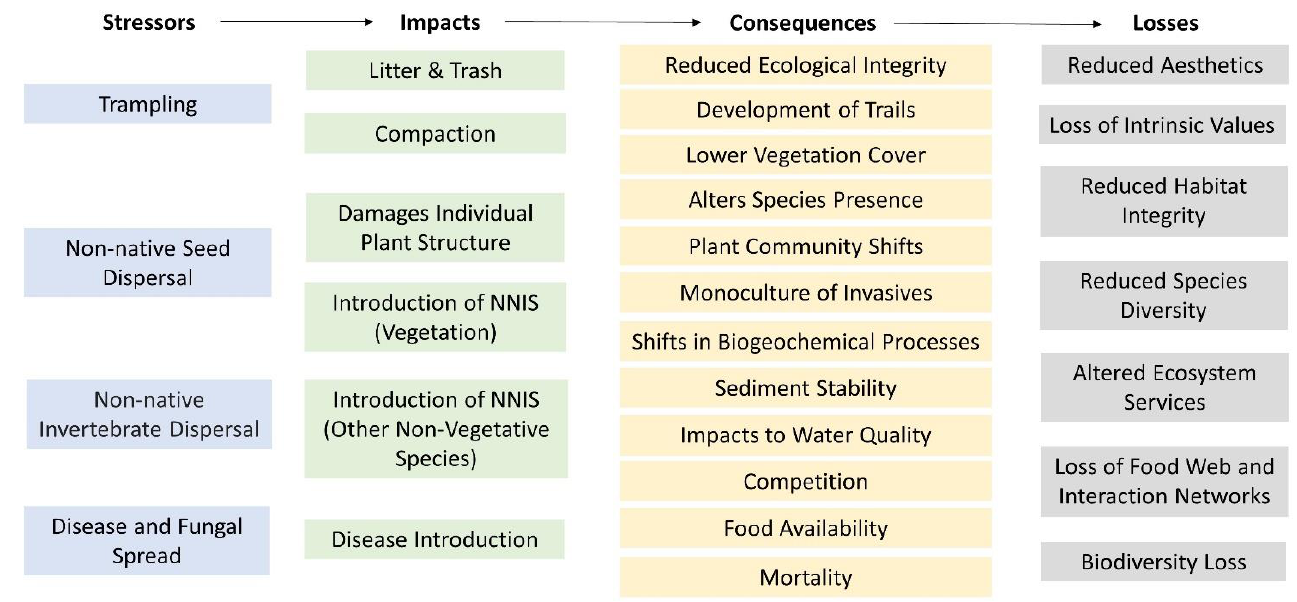
Figure 1. Researcher-induced stressors degrade ecosystem attributes down a linear pathway, pro- gressing from impacts to consequences to ecosystem losses. NNIS = Non-native invasive species.